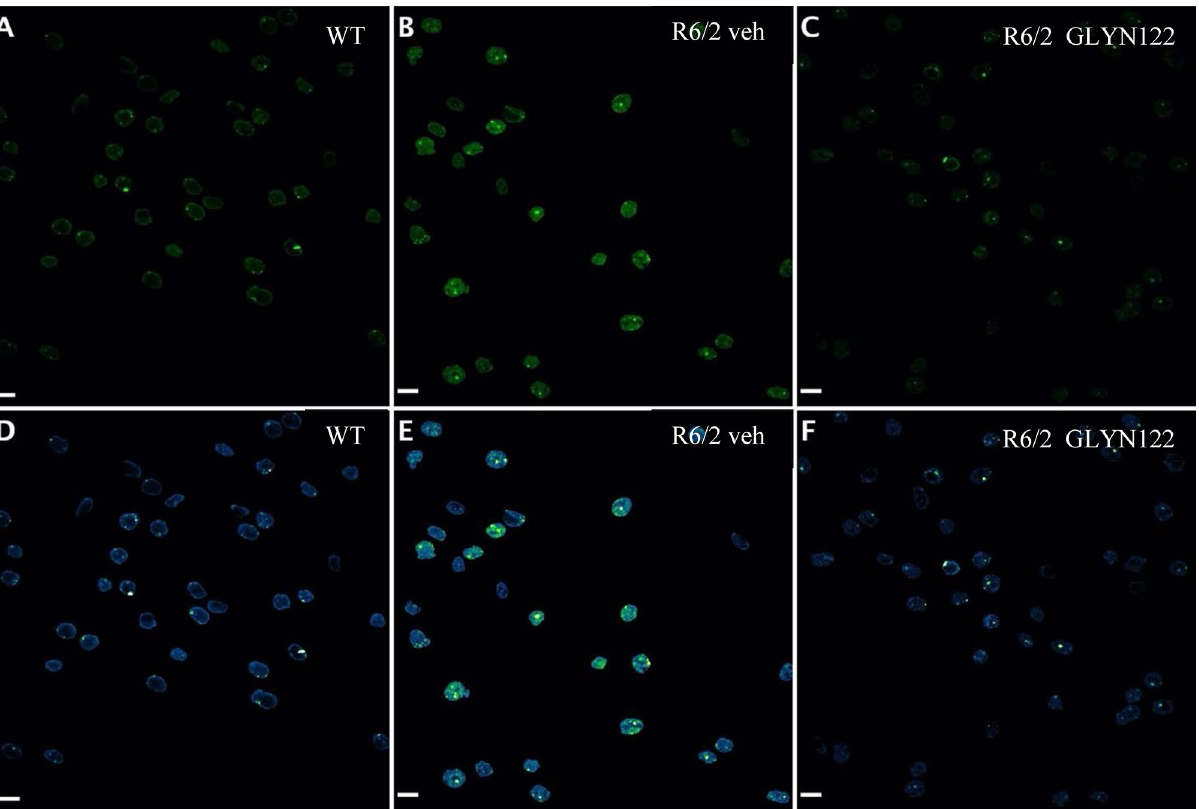
Figure 5. Confocal fluorescence images of the striatum region from WT vehicle (5A,5D), TG vehicle (5B,5E), and TG GLYN122 (5C,5F) samples labeled with EM48 mHTT antibody and detected with a fluorophore in the 488 nm channel. Grayscale images were pseudocolored with LUT “green” (top row) and “Green Fire Blue” (bottom row) in Fiji to visualize the gradient in signal intensities. For the latter LUT, increasing signal intensities are represented from blue to green to white. Overall, the strongest mHTT signal was visible in TG vehicles, while both WT vehicles and TG GLYN122 displayed decreased signals. Scale bars = 10 µm. WT wildtype, veh vehicle, TG transgenic. LUT Lookup